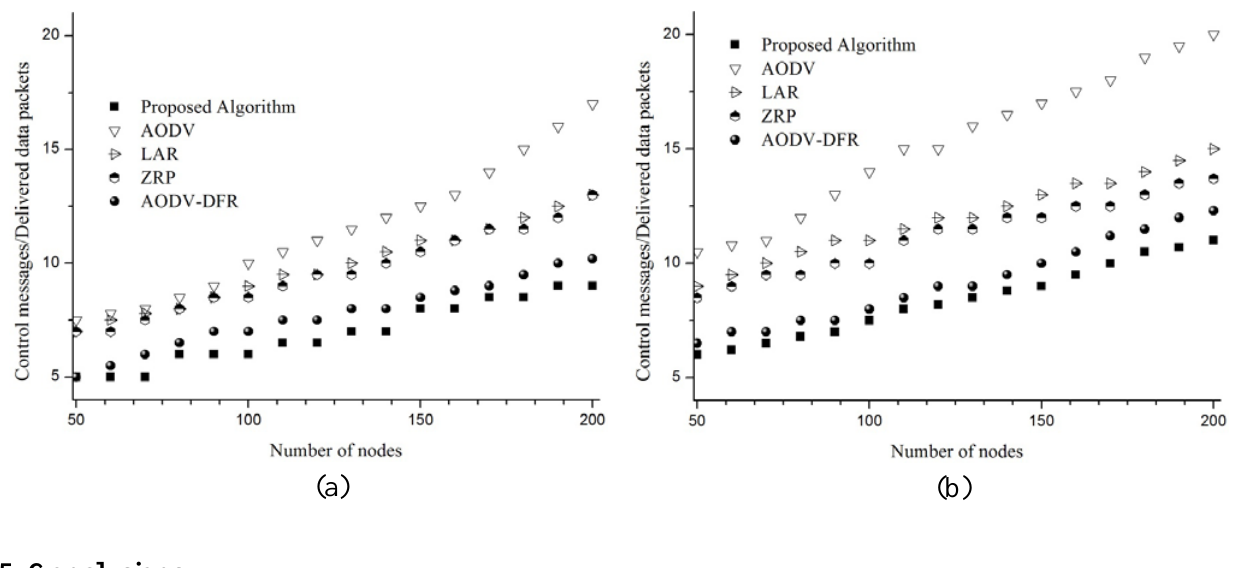
Figure 9. Number of control messages per delivered message. (a) 5 m/s node movement; (b) 20 m/s node